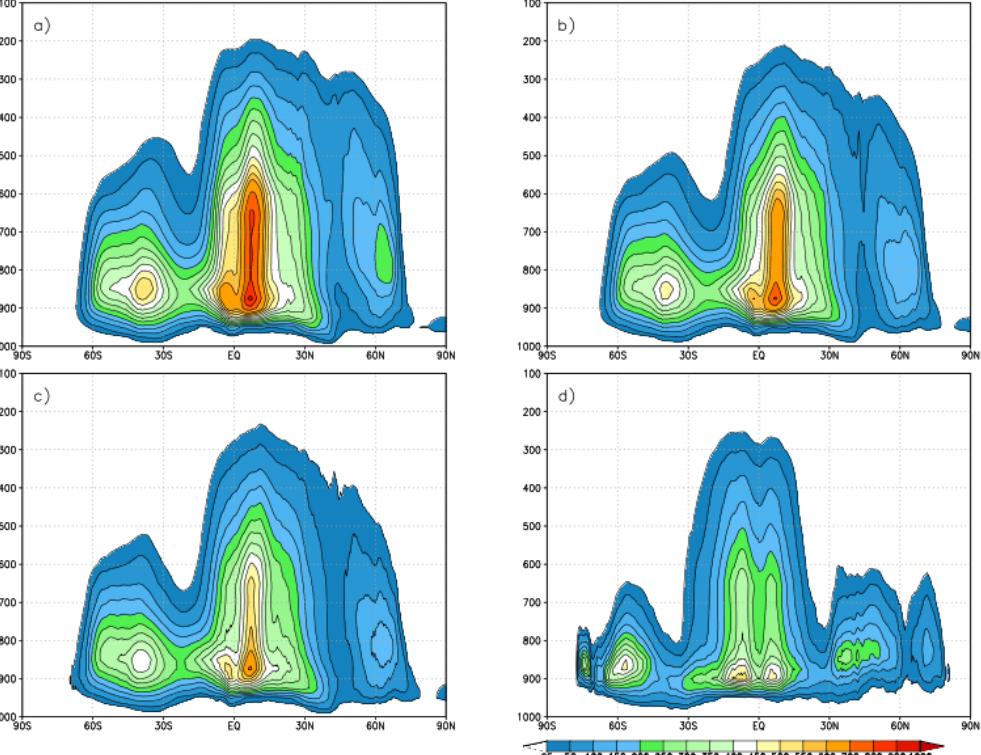
Figure 18. June-July-August seasonal mean cumulus mass flux in kgm − 2 day − 1 from MERRA2-like AGCM for (a) 1-degree resolution, (b) 1 / 2-degree resolution, (c) 1 / 4-degree resolution, (d) 10km